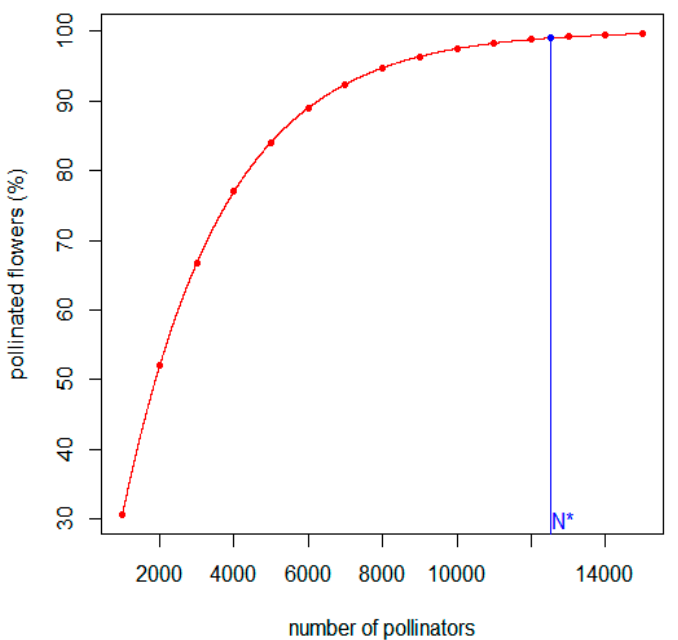
Figure 1. Ninety-nine percent of 700,000 open flowers are visited by pollinator during 6 h in a 10,000 m 2 greenhouse, if τ s = 24 s, τ h = 60 s, and there are N * = 12,536 pollinators, i.e., 1.2536/m 2 . Observe that for an 80% pollination, 6000 adult pollinators are needed, but for a 95% pollination already 12,000 adult pollinators are necessary, since during the day the pollinators find a virgin flower with lower and lower probability.